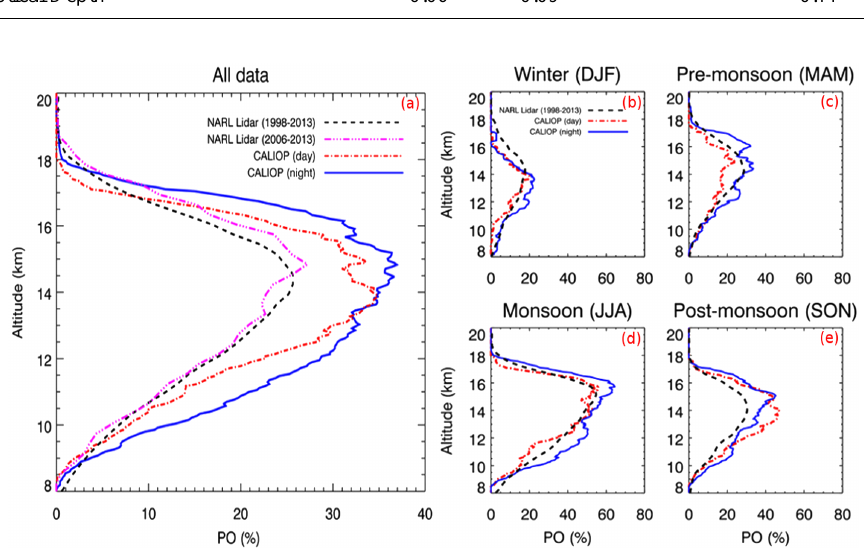
Figure 2. (a) Climatological altitude distribution of PO of cirrus clouds obtained from NARL Lidar data for the period 1998–2013 (dashed black line), NARL Lidar data during half an hour time window centred at 02:03LT for the period 2006–2013 (triple dotted-dashed magenta line), CALIOP daytime (single dotted dashed red line) and CALIOP night-time (solid blue line) data sets for the period 2006–2013. (b) Same as (a) but for winter (DJF), (c) pre-monsoon (MAM), (d) monsoon (JJA), and (e) post-monsoon (SON)